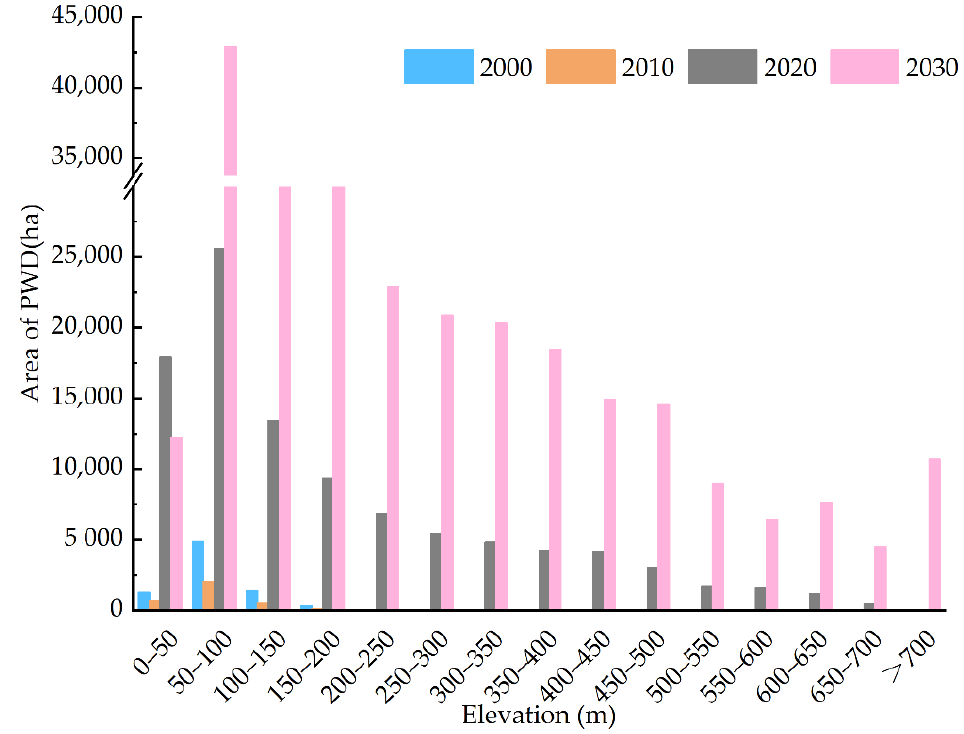
Figure 10. Statistics of vertical distribution of PWD along altitude.